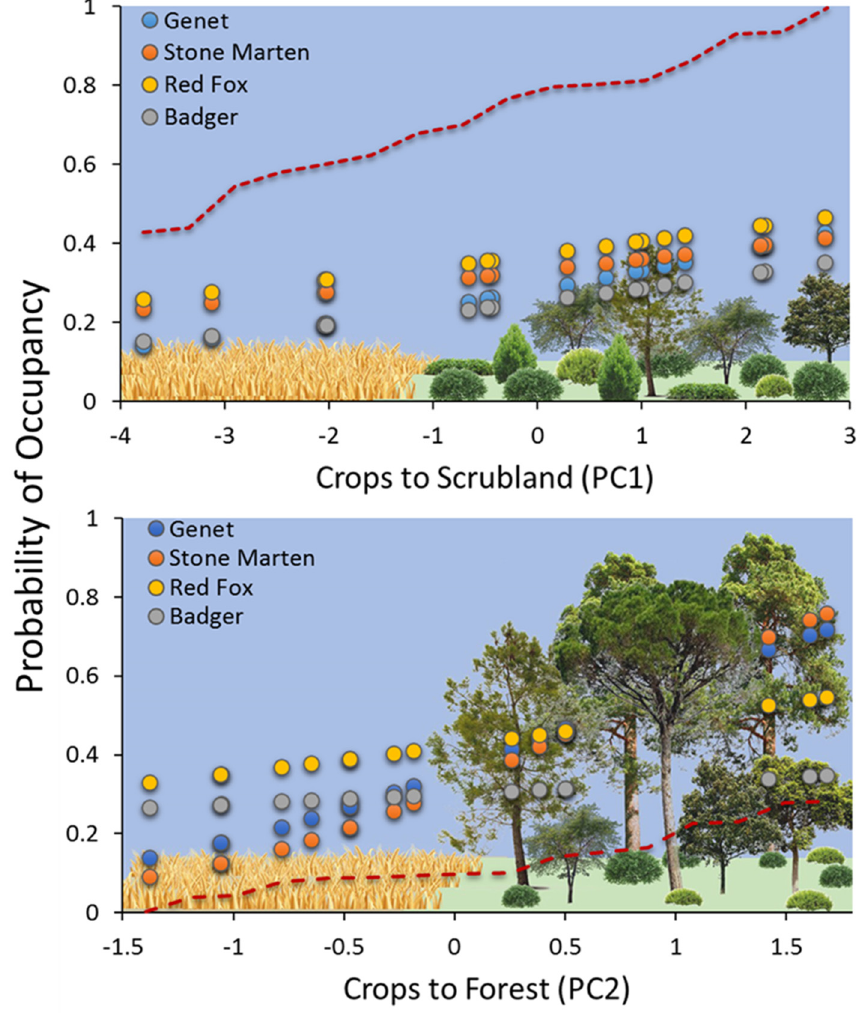
Figure 4. Modelled probability of occupancy of the four wild mesocarnivore species along gradients of landscape composition; PC1: gradient from crops to scrublands (79% of variance explained); PC2: gradient from crops to forests (19% of variance explained). Red shaded lines indicate the proportion of both scrubland and woodland in transects along the landscape gradients.